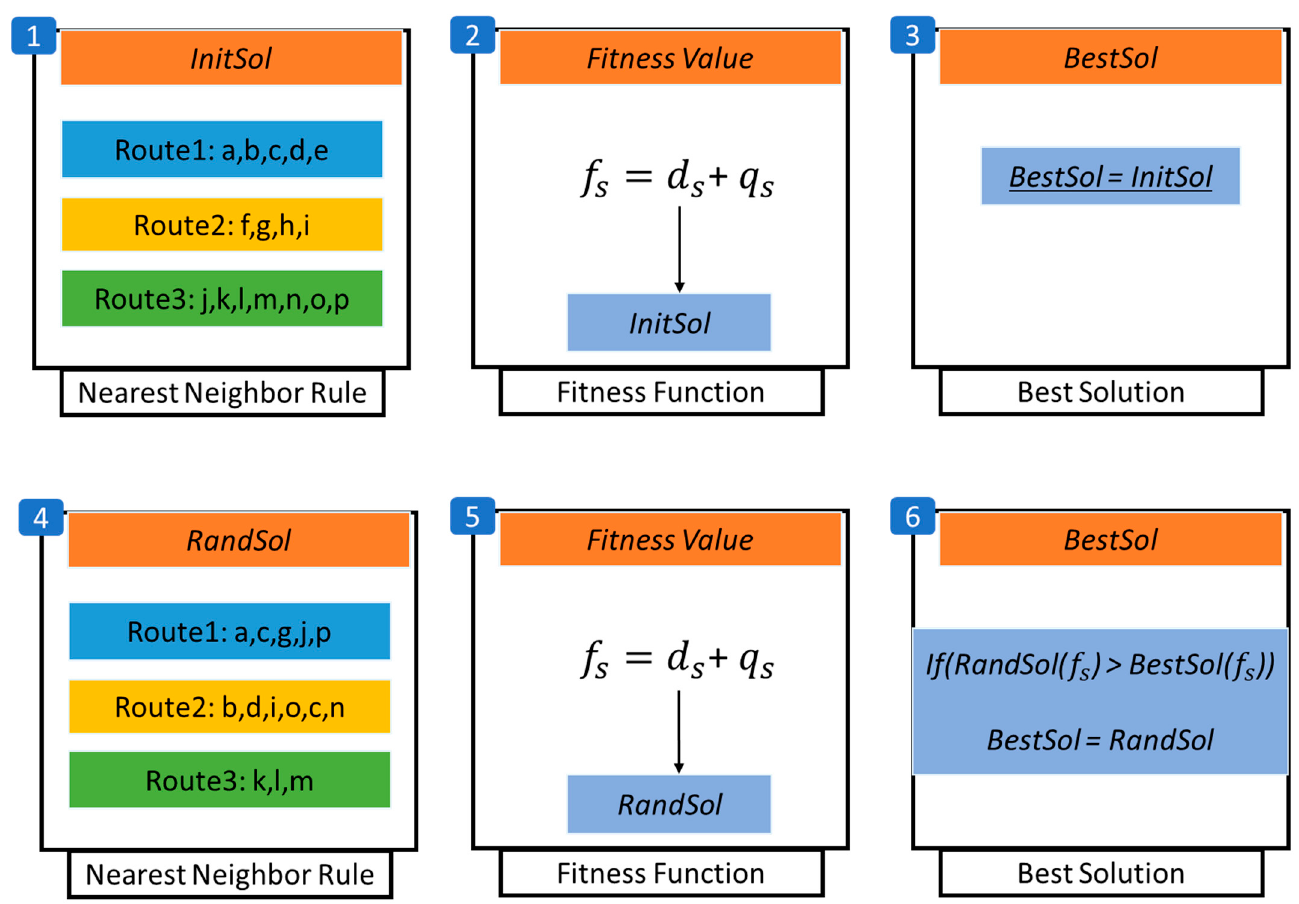
Figure 8. Steps of the route determination algorithm.